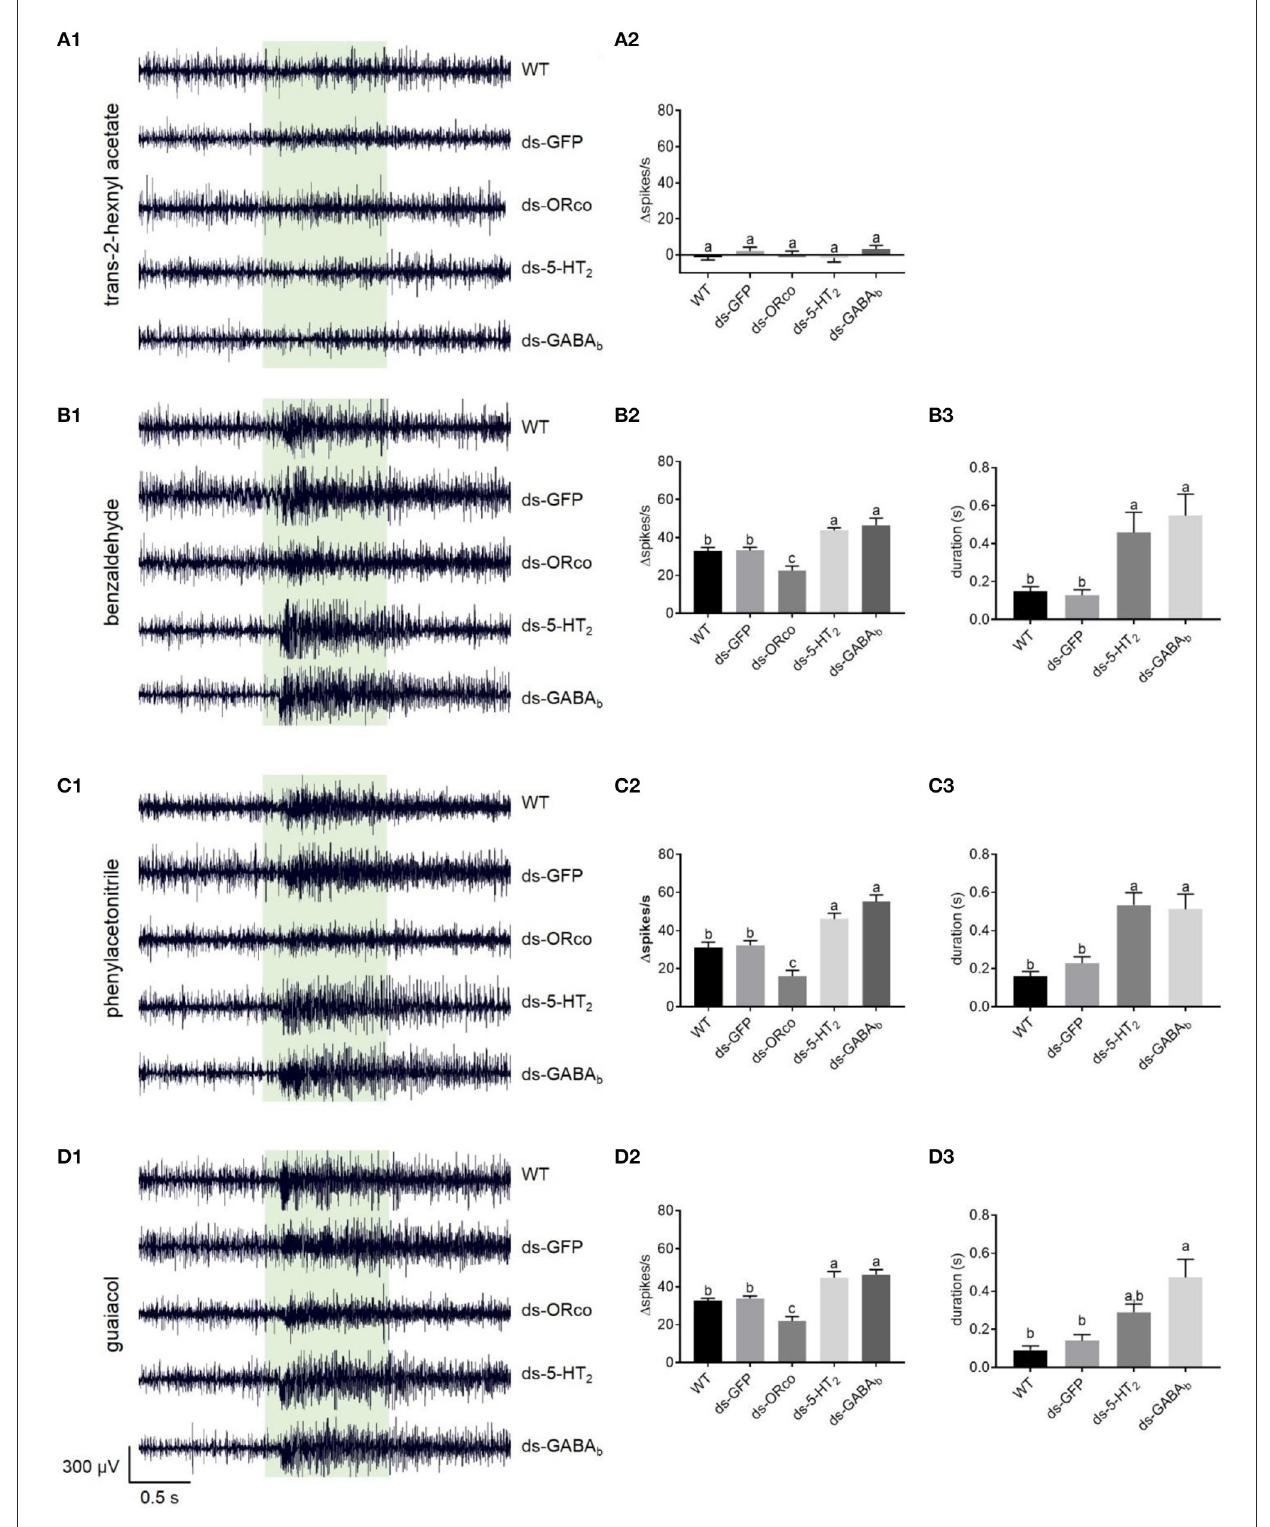
FIGURE5 Responses to odorants at 1% (v/v) concentration of ORNs in the antennal basiconic sensilla of wild-type locusts and locusts microinjected with ds-GFP, ds- Lmig Orco, ds- Lmig 5-HT 2 , or ds- Lmig GABA b . (A1–D1) Response traces of Ba6 neurons to trans-2-hexenyl acetate, benzaldehyde, phenylacetonitrile, and guaiacol. (A2–D2) Quantification of the mean changes of all spikes ( 1 spikes/s) in the 1s before and after the stimulus of the Ba6 neurons to odorants in wild-type locusts and locusts microinjected with ds-GFP, ds- Lmig Orco, ds- Lmig 5-HT 2 , or ds- Lmig GABA b . (B3–D3) Quantification of the duration from the maximum point of frequency after simulation to a 50% reduction of the response to odorants in the treated locusts. The green box indicates the stimulus duration (1s). WT, wild-type locusts; ds-GFP, locusts injected with ds-GFP; ds-Orco, locusts